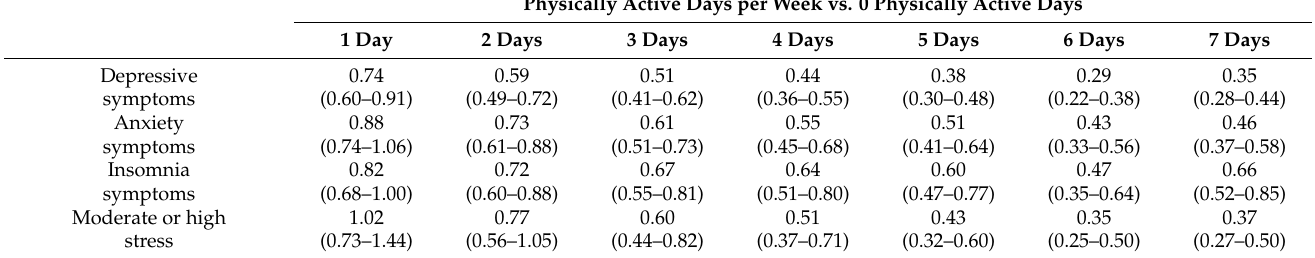
Table 4. Adjusted odds ratios and their 95% confidence intervals for different categories of physically activity vs. physically inactivity.